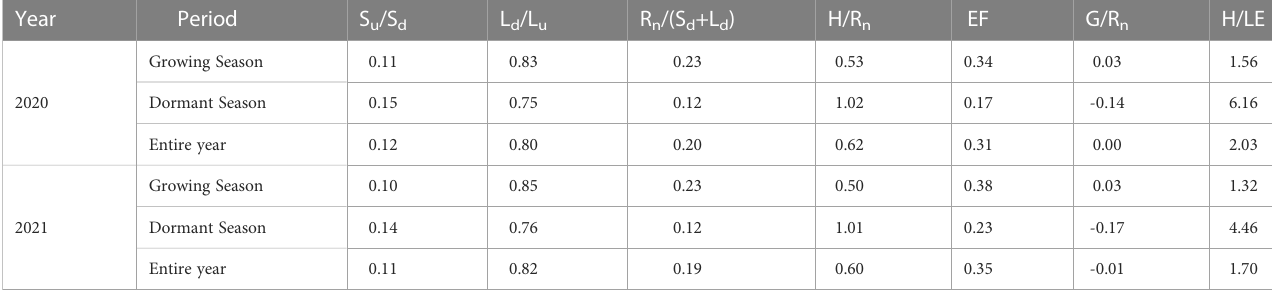
TABLE A2 Energy partitioning during the growing season, the dormant season, and the entire year in 2020 and 2021.